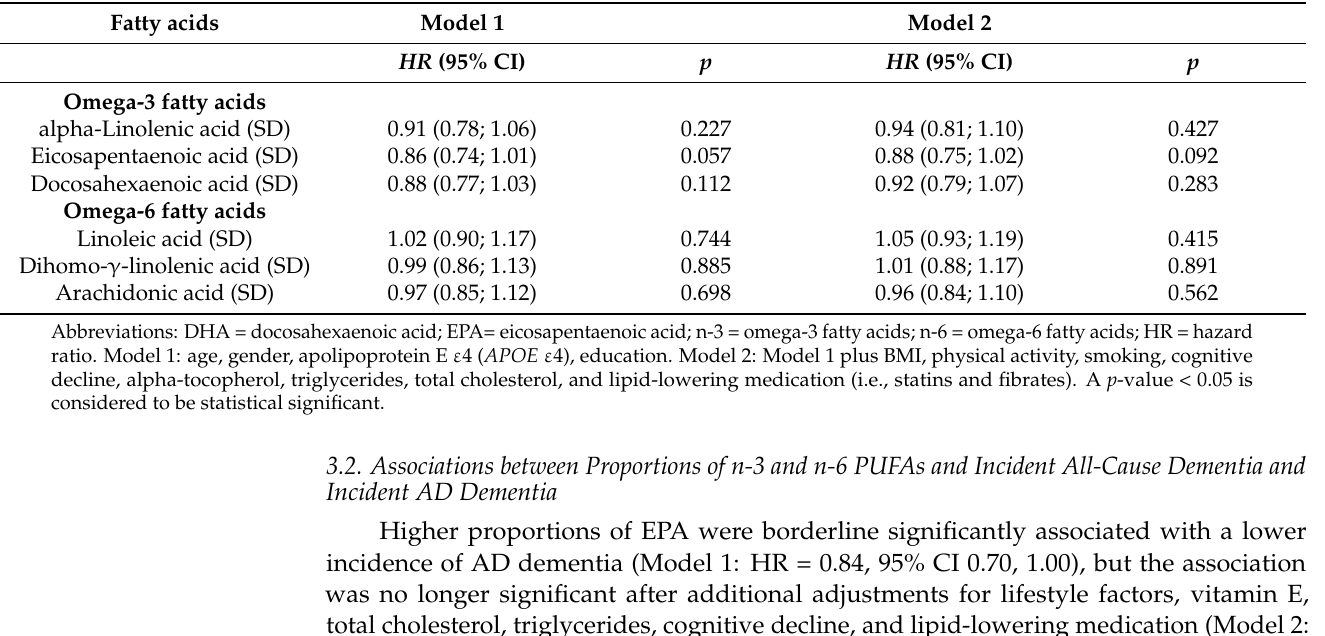
Table 3. Longitudinal associations between concentrations of n-3 and n-6 fatty acids in serum phospholipids and incident all-cause dementia over a 7-year follow-up period ( n =